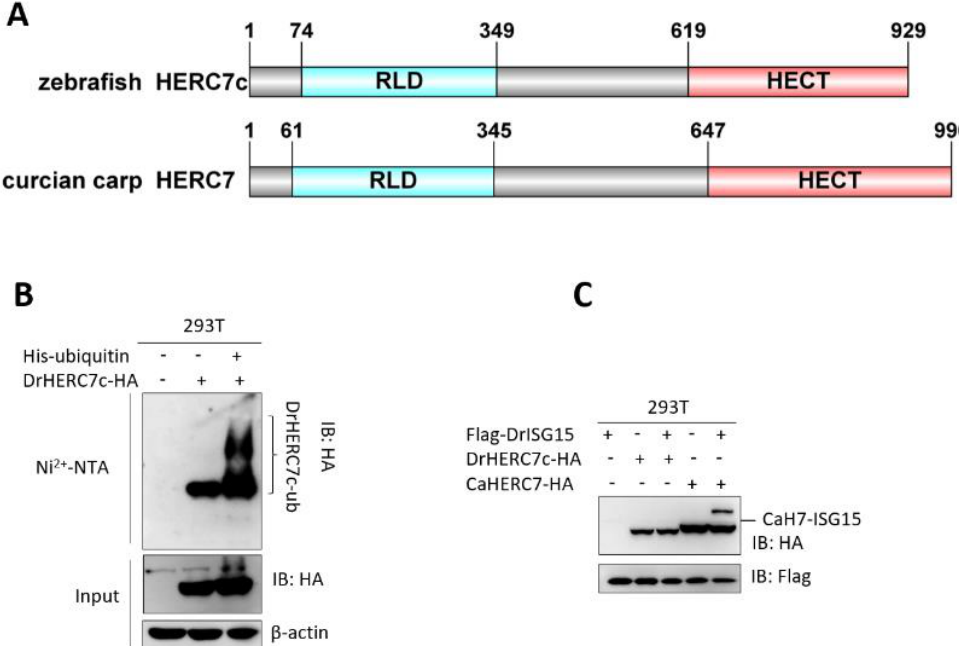
Figure 8. Zebrafish HERC7c is an E3 ligase for the conjugation of ubiquitin rather than ISG15. ( A ) Schematic diagram of zebrafish HERC7c protein and crucian carp HERC7 protein. ( B ) Polyubiqui- tination of zebrafish HERC7c. HEK293T cells plated in 10 cm 2 dishes overnight were transfected with 5 μg zebrafish HERC7c-HA together with or without 4 μg His-Ub. After 30 h, cells lysates were incubated with Ni 2+ -NTA resin, followed by Western blotting. ( C ) ISGylation of crucian carp HERC7 but not of zebrafish HERC7c. HEK293T cells plated in 10 cm 2 dishes were transfected with zebrafish HERC7c-HA or crucian carp HERC7-HA (5 μg each), together with or without 5 μg Flag-ISG15. After 30 h, the cells were collected for Western blotting.